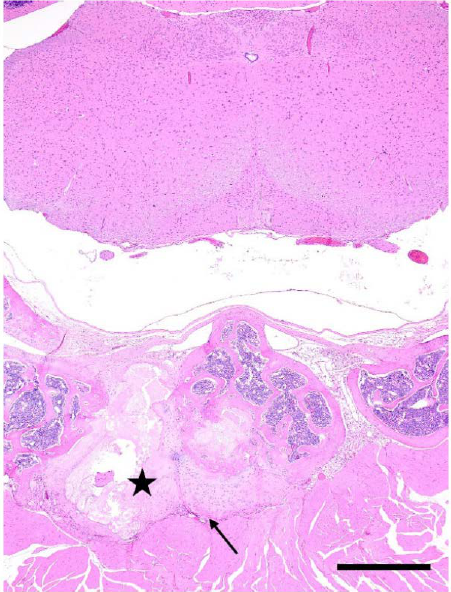
Figure 2. Example of avulsion fracture of the axis (2nd cervical vertebra). Photomicrograph of the atlanto-occipital and atlanto-axial joints. The bone of the axis is regionally fractured with chondromu- cinous degeneration (star), and cartilaginous callus formation (black arrow). H&E stain. Scale bar, 500 µ